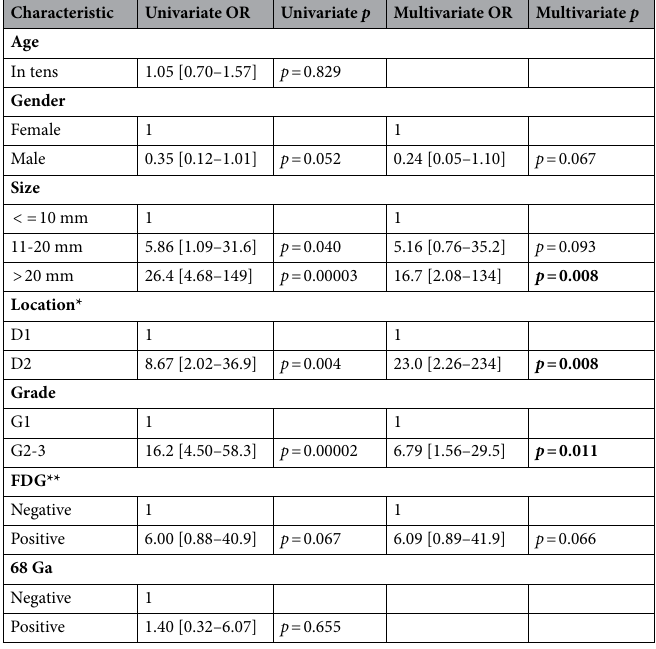
Table 4. Summary of univariate and multi-variate analysis for all non-functioning dNENS to predict liver metastases. *Location was multi-collinear with FDG and size, so was analysed in a separate multivariate